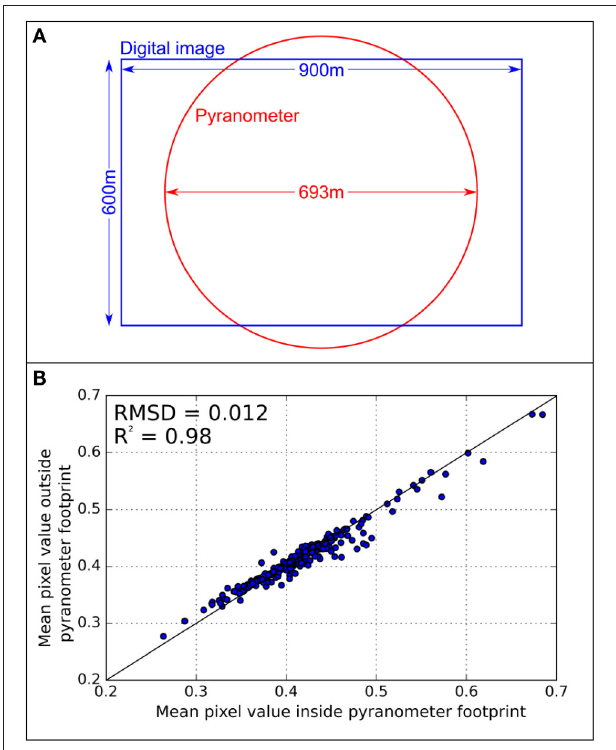
FIGURE 4 | (A) Footprint difference between the downward facing pyranometer and digital camera. (B) Relationship between image pixels inside and outside the pyranometer footprint are well